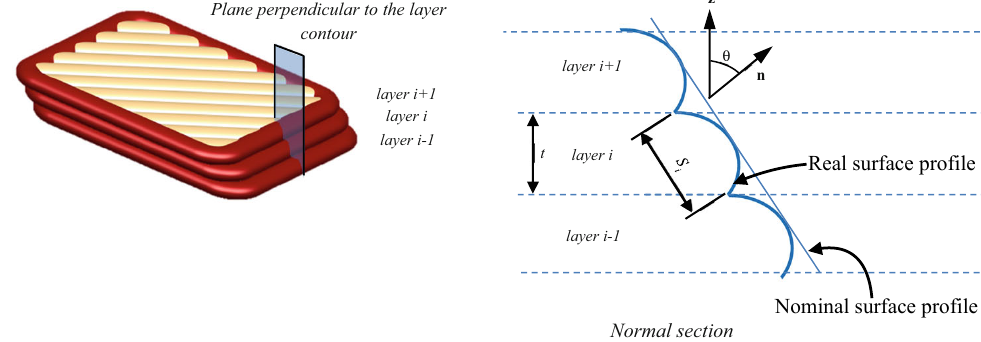
Figure 1. Stair-stepping effect: the nominal surface and the real surface are not coincident.